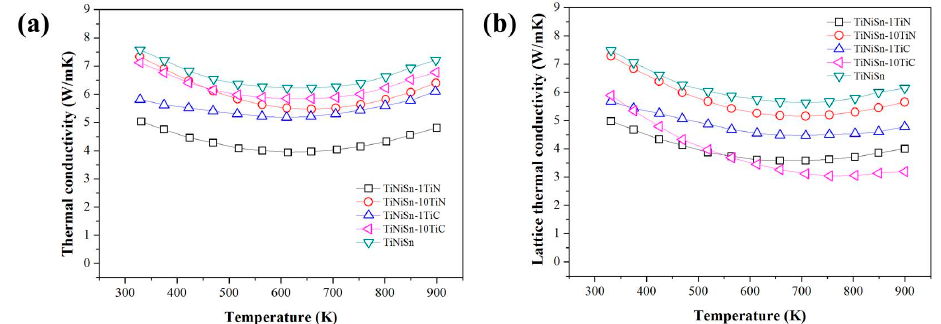
Figure 4. ( a ) The thermal conductivity and ( b ) lattice thermal conductivity of TiNiSn, TiNiSn-1TiN, TiNiSn-10TiN, TiNiSn-1TiC, and TiNiSn-10TiC.